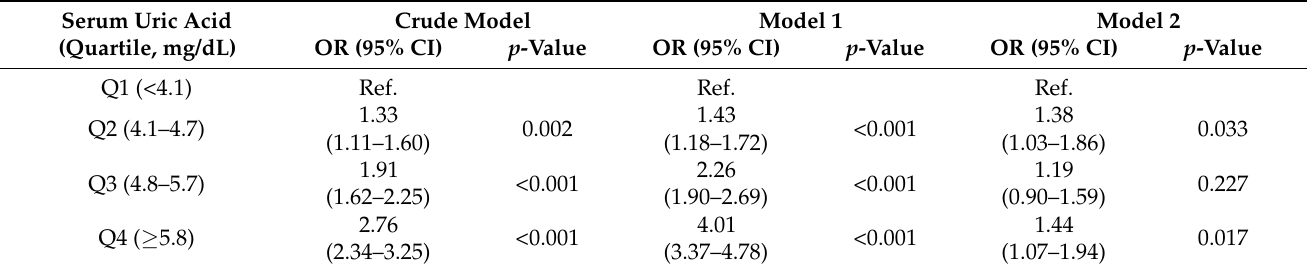
Table 4. The association between serum uric acid quartile and having a high CVD